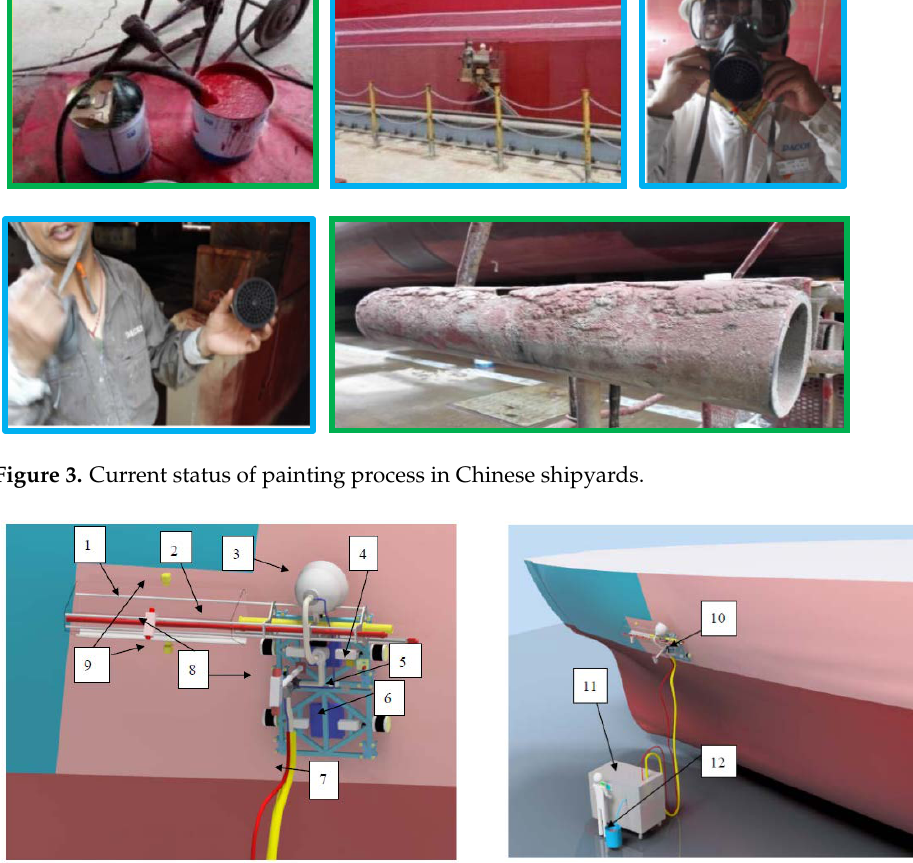
Figure 4. Proposed design of paint mist-recoverable painting robot: ( a ) Wall-climbing robot carrier for spraying equipment; ( b ) Complete coating wall climbing system: 1. paint mist shield; 2. combined spray gun inside the paint mist shield; 3. reciprocating paint mist shield; 4. temperature, humidity, air pressure and wind speed sensor unit; 5. flexible hinge connection joint; 6. safety anti-fall fast suction unit; 7. feed tube and vacuum recovery tube; 8. vision camera; 9. ultrasonic paint film thickness detection module; 10. vision of the wall crawling robot body; 11. automatic traction of the feed and vacuum recovery mini container; 12. self-priming material drum.